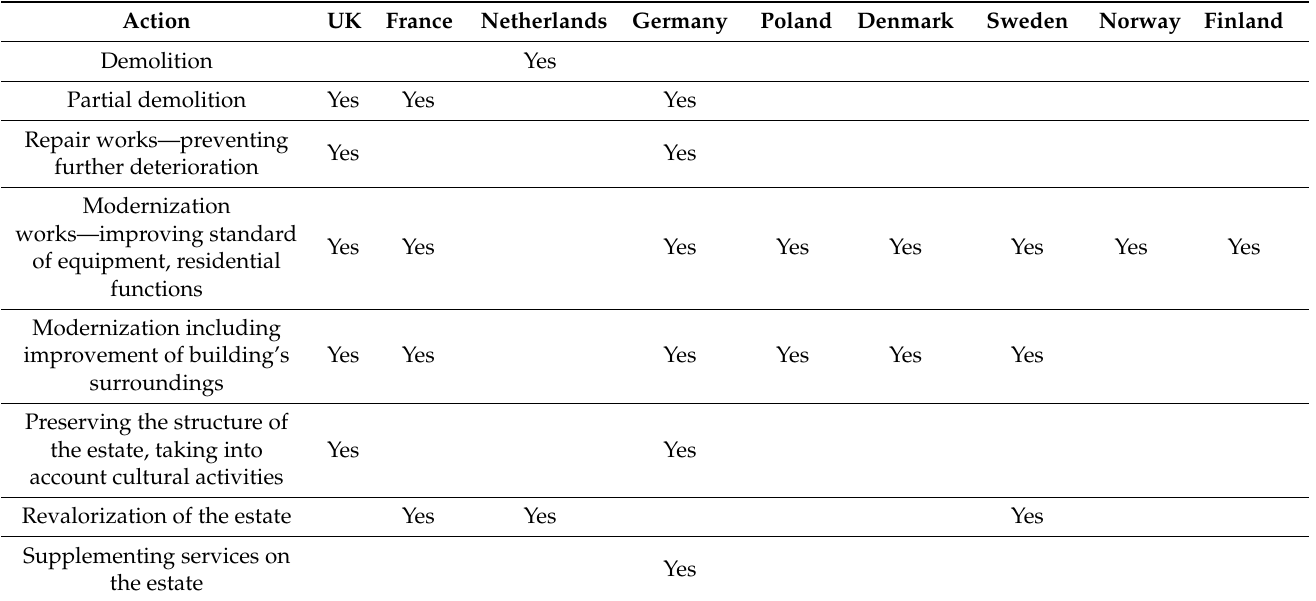
Table 6. Trends of revitalization in selected European countries (based on the information provided in